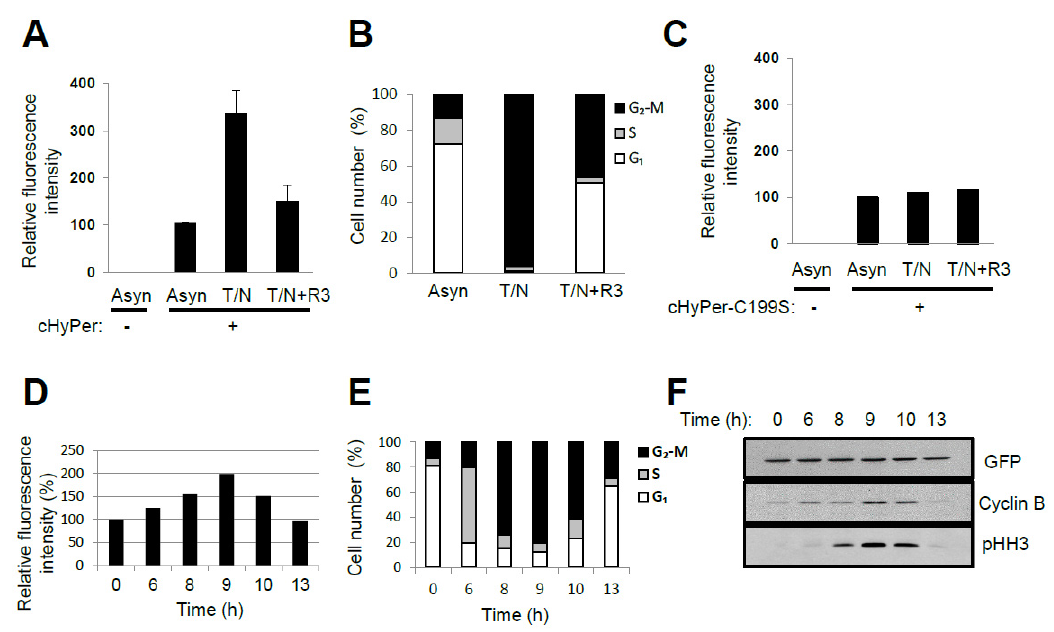
Figure 3. Oscillation of H 2 O 2 levels during the cell cycle (experimental data by the authors): ( A,B ) HeLa cells expressing cytosolic HyPer (cHyPer) were arrested at prometaphase by treatment with thymidine and nocodazole (T/N) and then released into G 1 phase by shaking off into fresh medium and incubation for 3 h (T/N+R3). The fluorescence intensity of cHyPer was measured by flow cytometry, and the relative levels of H 2 O 2 were estimated ( A ) for asynchronous, T/N, and T/N+R3 cells. Asynchronous HeLa cells that were not transfected with the cHyPer vector were analyzed similarly. Cell cycle status was also determined by flow cytometric analysis after staining with propidium iodide ( B ). Data in ( A ) are means ± SD from three independent experiments. ( C ) The relative fluorescence intensity of cHyPer–C199S was measured as in ( A ). Data are from a representative experiment. ( D–F ) HeLa cells expressing cHyPer were arrested at G 1 –S with a double-thymidine block and released into fresh medium. The relative levels of H 2 O 2 were measured by flow cytometry at the indicated times after the release ( D ). Cell cycle status was also analyzed by flow cytometry after staining with propidium iodide ( E ), and the expression of cell cycle marker proteins was examined by immunoblot analysis ( F ). cHyPer is detected with antibodies to green fluorescent protein. Data are from a representative experiment. pHH3, phosphorylated histone H3. Rabbit polyclonal antibodies to Ser 10 -phosphorylated histone H3 (pHH3) (from Upstate Biotechnology) were used to detect mitotic cells. For analysis of cell cycle stage, cells (5 × 10 5 /mL) were washed twice with ice-cold phosphate-buffered saline, fixed overnight at 4 °C in 70% ethanol, and stained with 1 mL of a solution containing RNase (50 μ g/mL) and propidium iodide (50 μ g/mL) before flow cytometry with a FACSCalibur instrument (BD Biosciences, Franklin Lakes, USA). For measurement of the intracellular level of H 2 O 2 , cells expressing cHyPer or cHyPer-C199S were analyzed at an excitation wavelength of 488 nm.